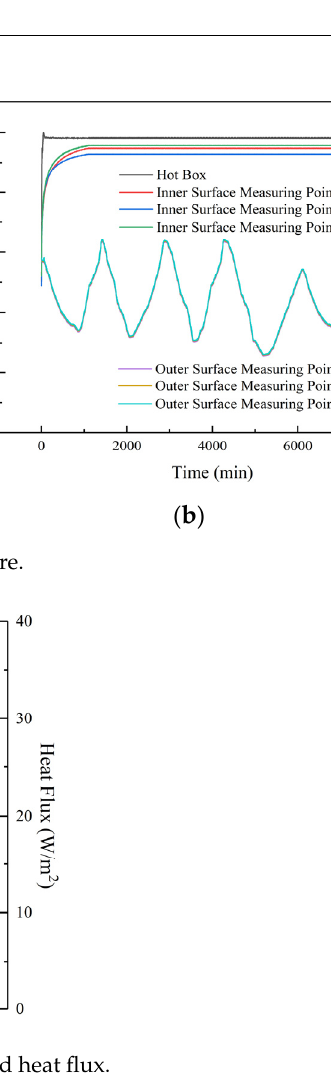
Figure 11. Specimens average surface temperature and heat flux.